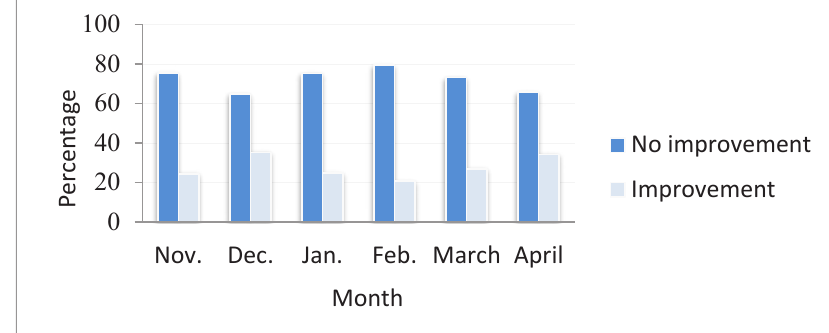
Figure 2. percentages of hemoglobin improvement in each month Figure 2. Percentages of hemoglobin improvement in each month.